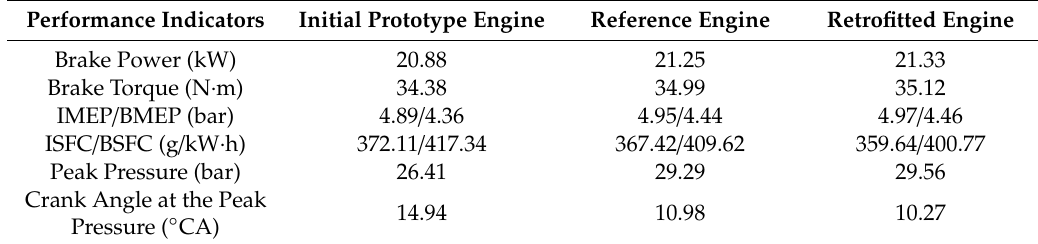
Table 22. Comparative simulation results of the medium load operation condition (heavy